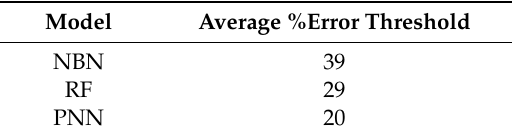
Table 10. Average percent classification error that leads to